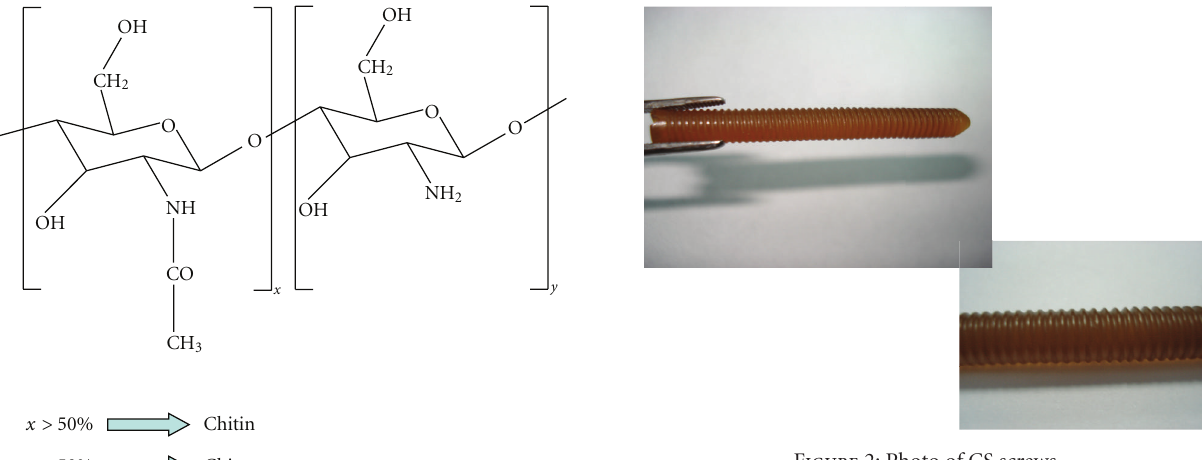
Figure 2: Photo of CS